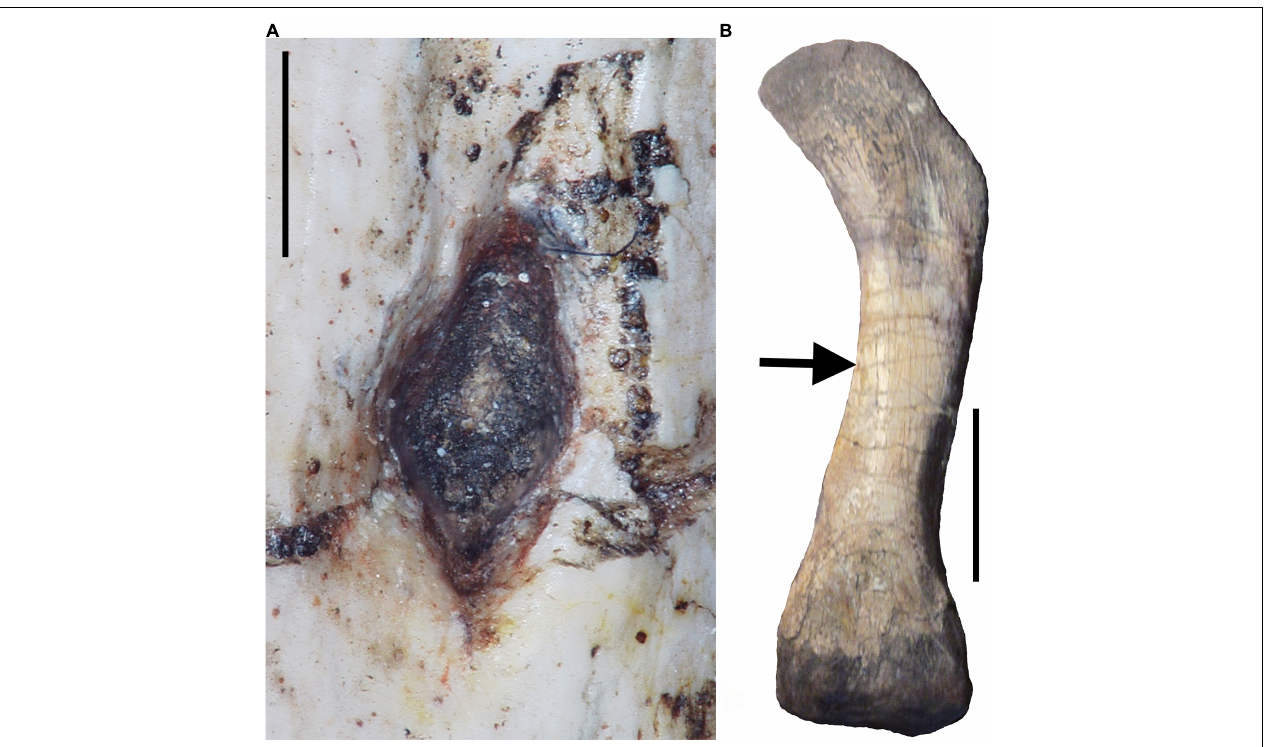
FIGURE 1 | Photographs of the left femur of the gorgonopsid therapsid Sauroctonus parringtoni [Paläontologische Sammlung, Universität Tübingen, Tübingen, Germany (GPIT/RE/7113)]. (A) Digital photomicrograph of the nutrient foramen. Note wide funnel that needs to be avoided when measuring nutrient foramen radius superficially. Scale bar equals 1 mm. (B) Photograph of entire femur in dorsal view with arrow indicating location of nutrient foramen. Scale bar equals 5